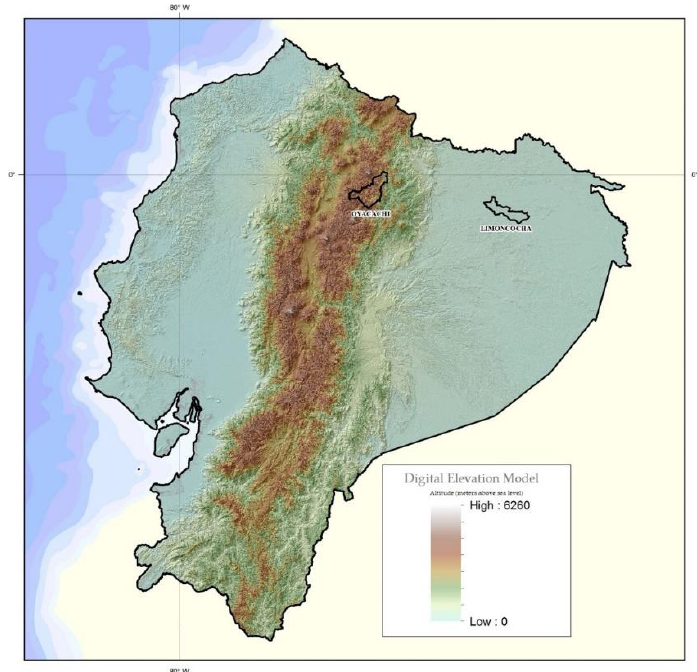
Figure 1. Topographic map of Ecuador highlighting Limoncocha (230 m) and Oyacachi (3800 m).